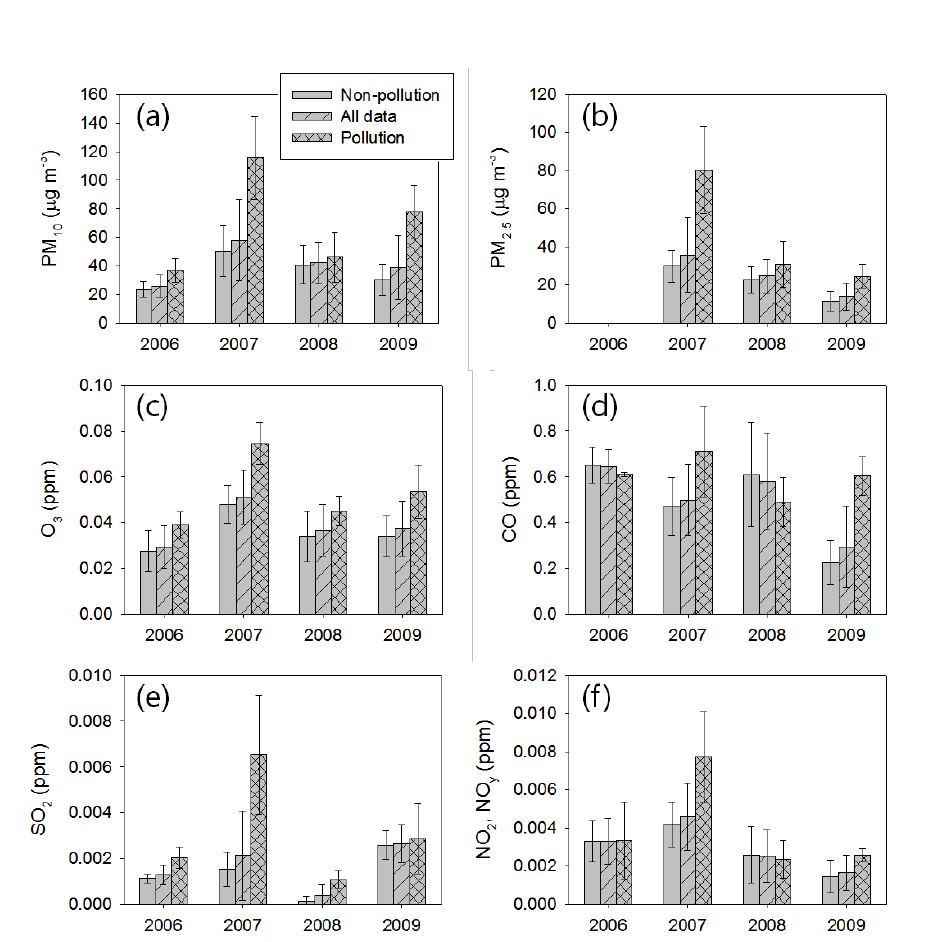
Fig. 4. Average concentrations of PM mass and of various gaseous species for each campaign. The error bars represent standard deviations Figure 4. Average concentrations of PM mass and of various gaseous species for each of each campaign. The error bars represent standard deviations of each measurement.